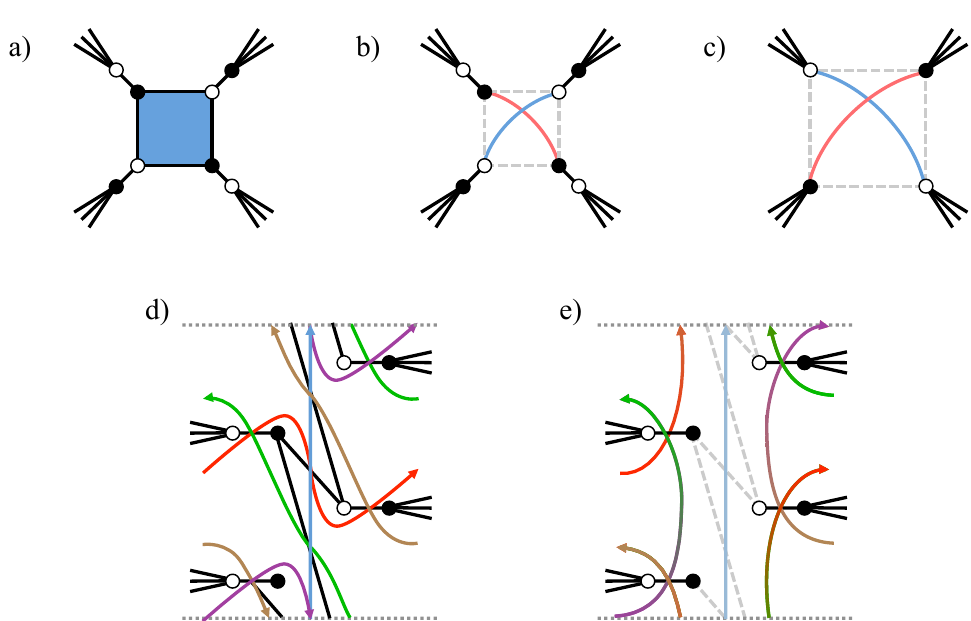
Figure 34. a) Seiberg dual of the local con(cid:12)guration in (cid:12)gure 33a. b) Backreacted BFT, with the identi(cid:12)cation of corner nodes indicated by bridges. c) After integrating out massive (cid:12)elds we obtain (cid:12)gure 33b. d) The Seiberg dual con(cid:12)guration in the mirror. The instanton wraps the length 4 blue 1-cycle. e) E(cid:11)ect of backreaction in the mirror.